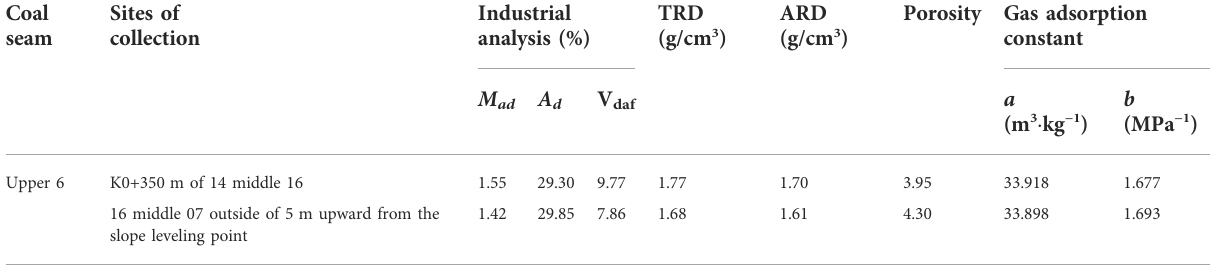
TABLE 1 Tested results of experimental parameters including the gas adsorption constant and industrial analysis indexes of upper coal seam 6. Coal seam